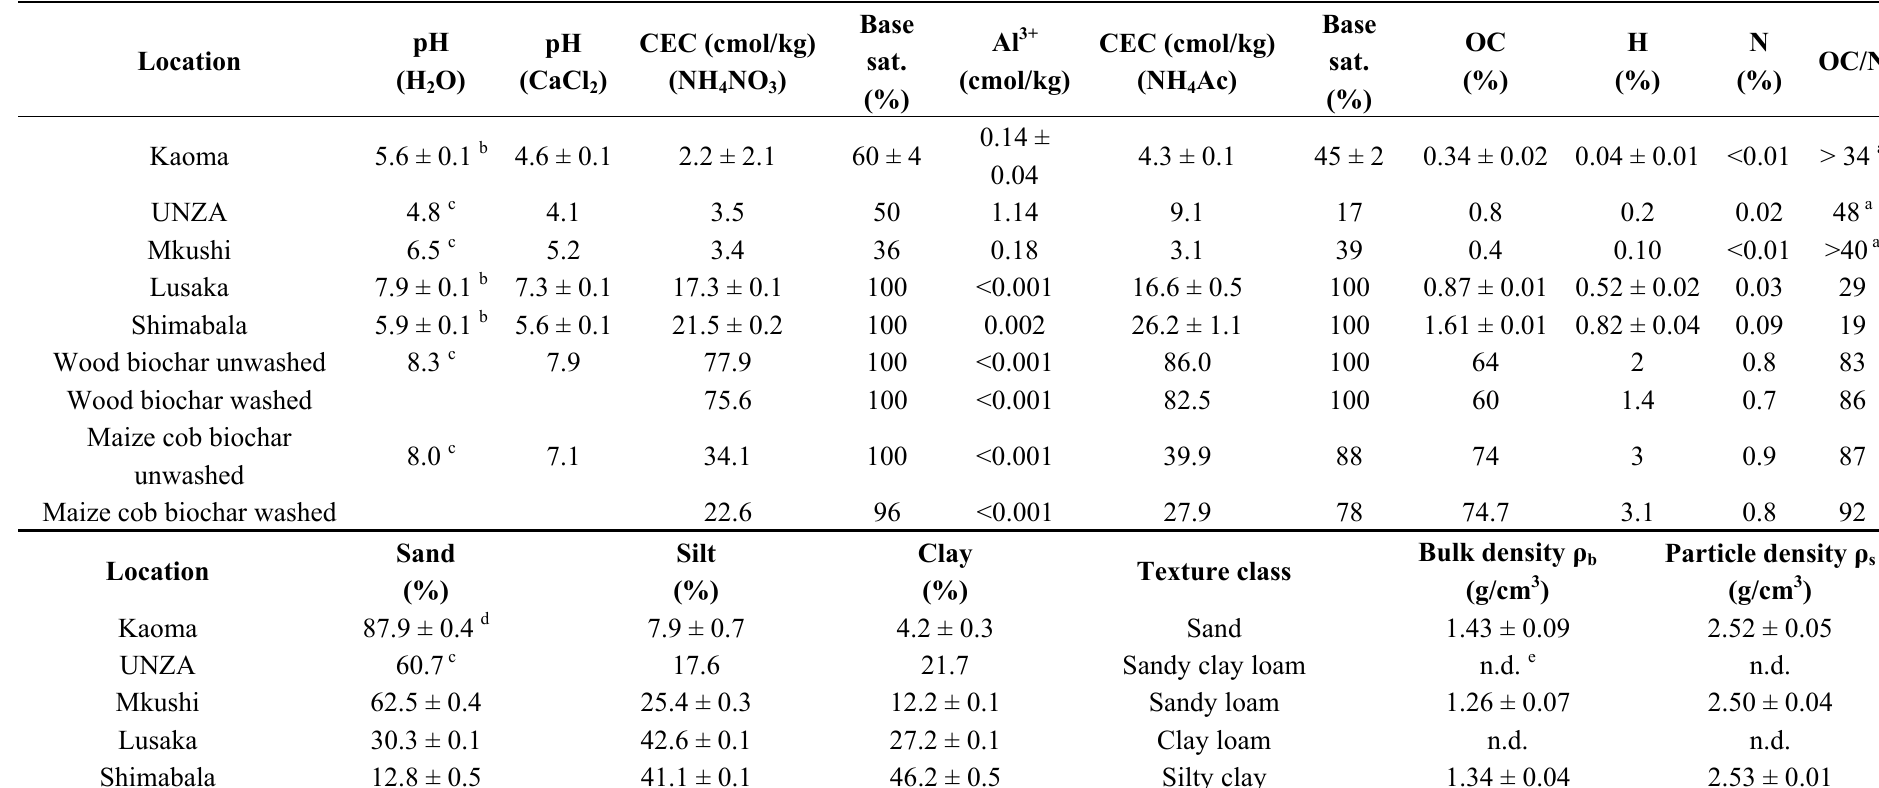
Table 3. Soil characteristics of the five field sites (0–15 cm depth) and the two biochars (washed and unwashed). n.d, not